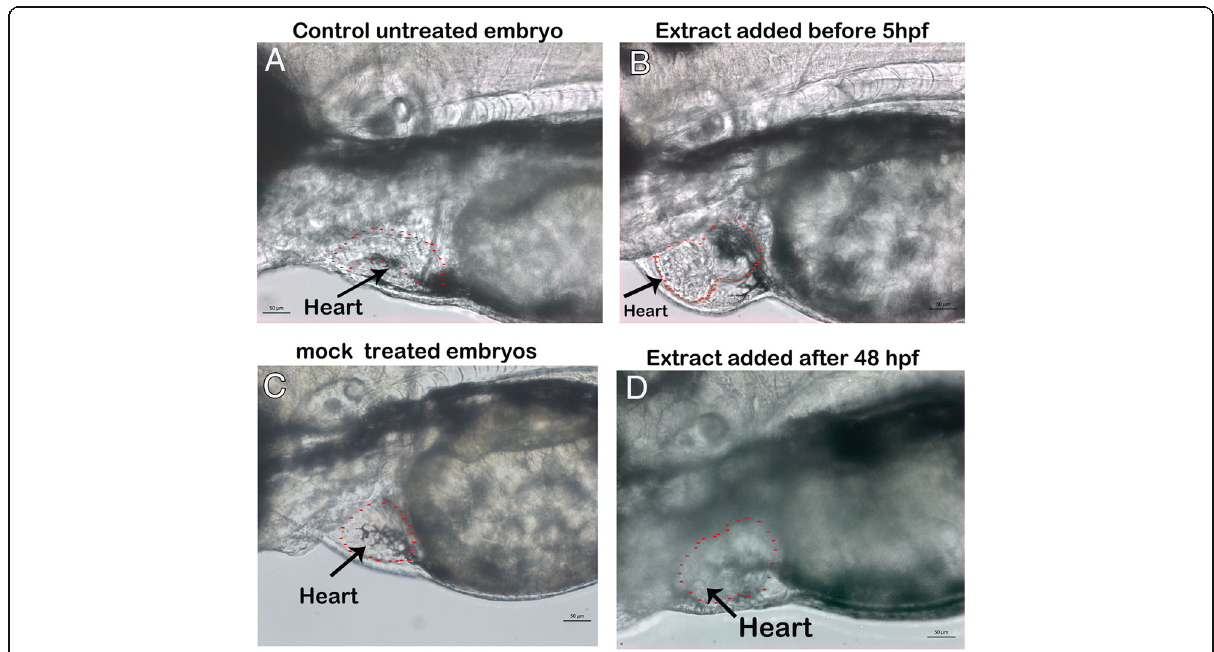
Fig. 5 The fruit extract of M .Charantia effected the heart formation not the heart growth in treated zebrafish embryos. Representative live photomicrograph of zebrafish embryos at 72 hpf. a : Untreated control embryos at 72 hpf showing the normal formation and development of heart (red dots area represented by arrow). b: Zebrafish embryos which were treated with fruit extract of M. charantia at one cells stage exhibited the cardiac hypertrophy (red dots area and black arrow). c: The mock (methanol 0.5% v/v) treated embryos which were treated with solvent at one cell stage had normally heart development. d: Zebrafish embryos which were exposed to fruit extract of M. charantia at 48 hpf also had normal heart formation and development (red dot area). Abbreviation hpf: hours post fertilization. Scale bar 50 μ